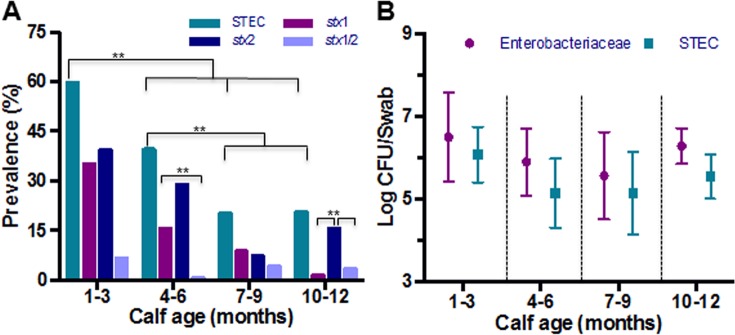
Prevalence and concentration of STEC in beef calves.(A) The prevalence of STEC, stx1 genotype, stx2 and stx1/stx2 isolated from calves at four times during the first year of life are presented. For comparisons among age groups, p-values are included along with the level of statistical significance (p-value < 0.05 **). (B) The concentration (log CFU/swab) of STEC and Enterobacteriaceae isolated from calves at four times during the first year of life are presented. Statistical comparisons among age groups were examined using simple logistic regression to determine differences in prevalence (A), as well as simple linear regression to determine differences in bacterial concentrations recovered from recto-anal junction swabs (B).